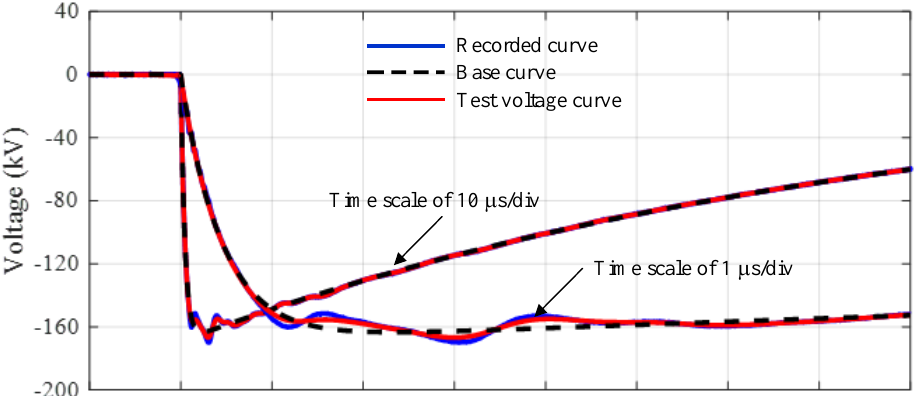
Figure 11. The assessed full lightning impulse waveforms in the LI-M5 case (waveform data provided by [13]).